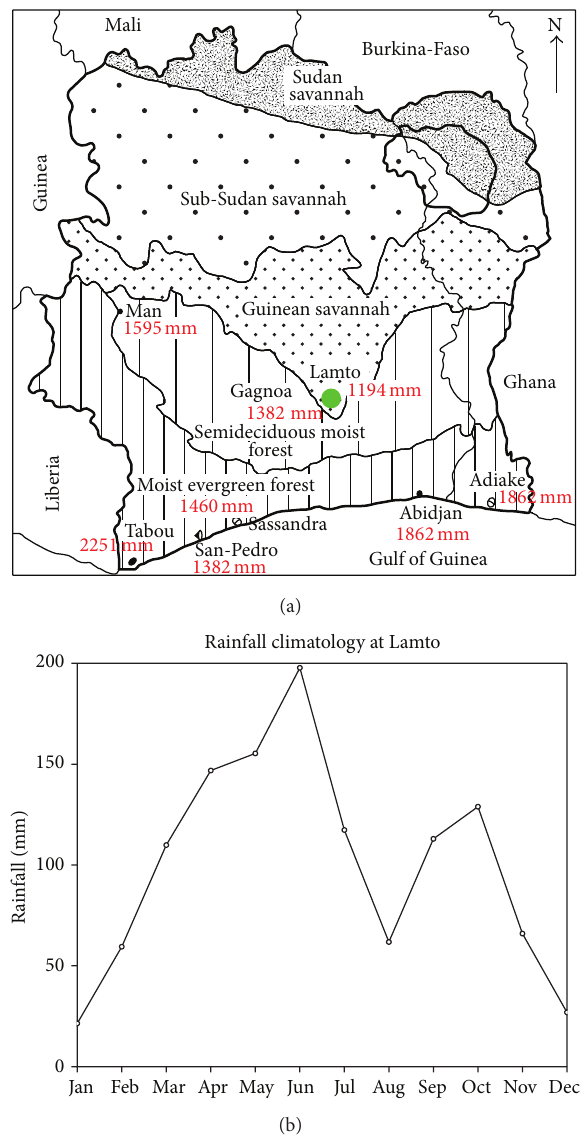
Figure 1: (a) Localization of the region of Lamto (5.02 ∘ W–6.13 ∘ N) represented by the green area. Numbers in red are the mean annual rainfall (1962–1997) of some synoptic stations (Adapted from Guil- lamet et Adjanohoun [24]). (b) Mean seasonal cycle of the rainfall at Lamto during